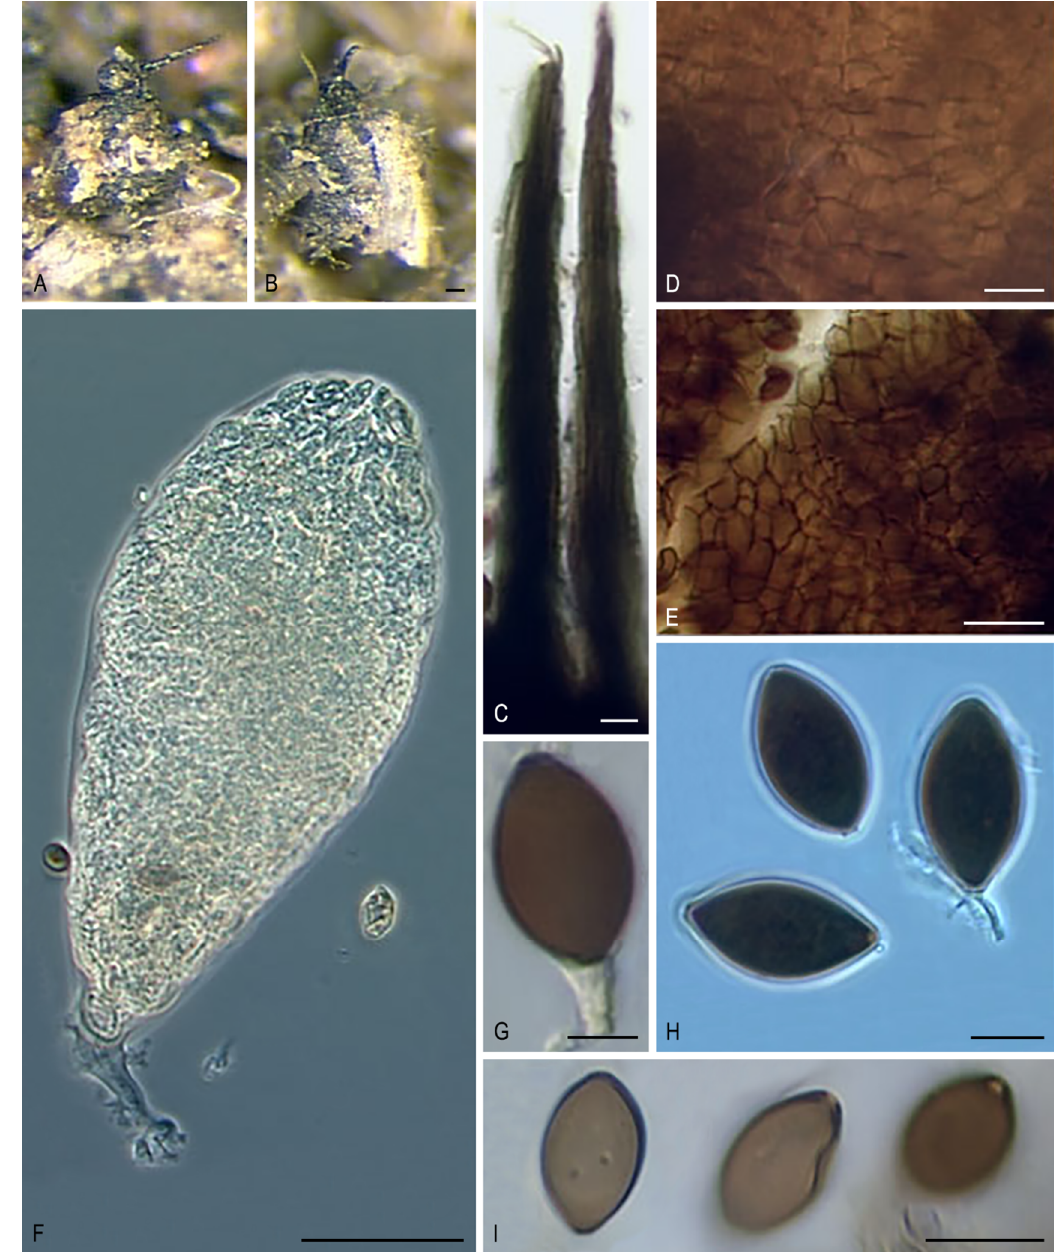
Figure 12 . Morphology of Pseudoechria. Ascoma. ( A , B ) Pseudoechria curvicolla SMH 4381. Tuft of rigid hair of the neck. ( C ) Pseudoechria curvicolla SMH 4381. Ascomatal wall. ( D ). Pseudoechria decidua CBS 254.71 T . ( E ). Pseudoechria prolifica CBS 250.71 T . Ascus. ( F ) Pseudoechria curvicolla SMH 4381. Ascospores. ( G ) Pseudoechria curvicolla SMH 4381. ( H ) Pseudoechria decidua CBS 254.71 T . ( I ). Pseudoechria prolifica CBS 250.71 T . Bars: ( A , B ) = 100 µm; ( C ) = 20 µm; ( D , E , H , I ) = 10 µm; ( F ) = 50 µm; ( G ) = 5 µm. Key to species of Pseudoechria